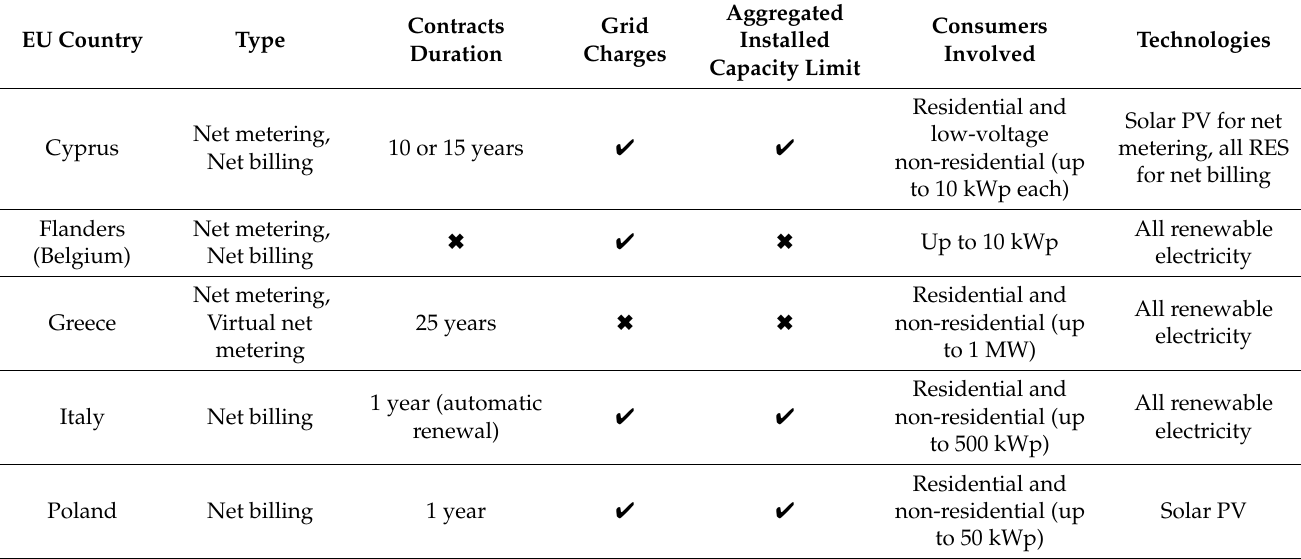
Table 2. Comparison of net-metering models in certain EU countries